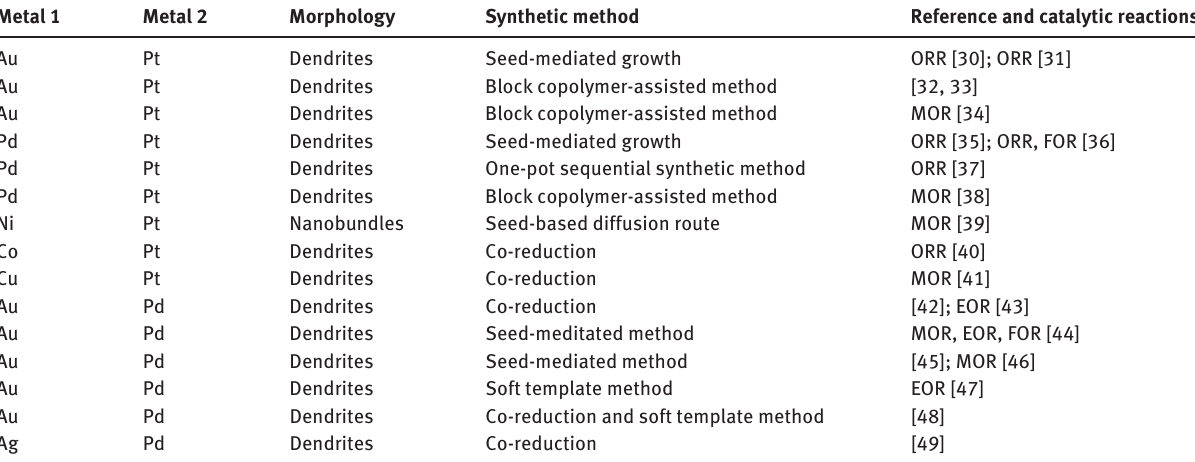
Table 1 List of dendritic Pt- and Pd-based bimetallic nanostructures, their synthetic methods, and catalytic